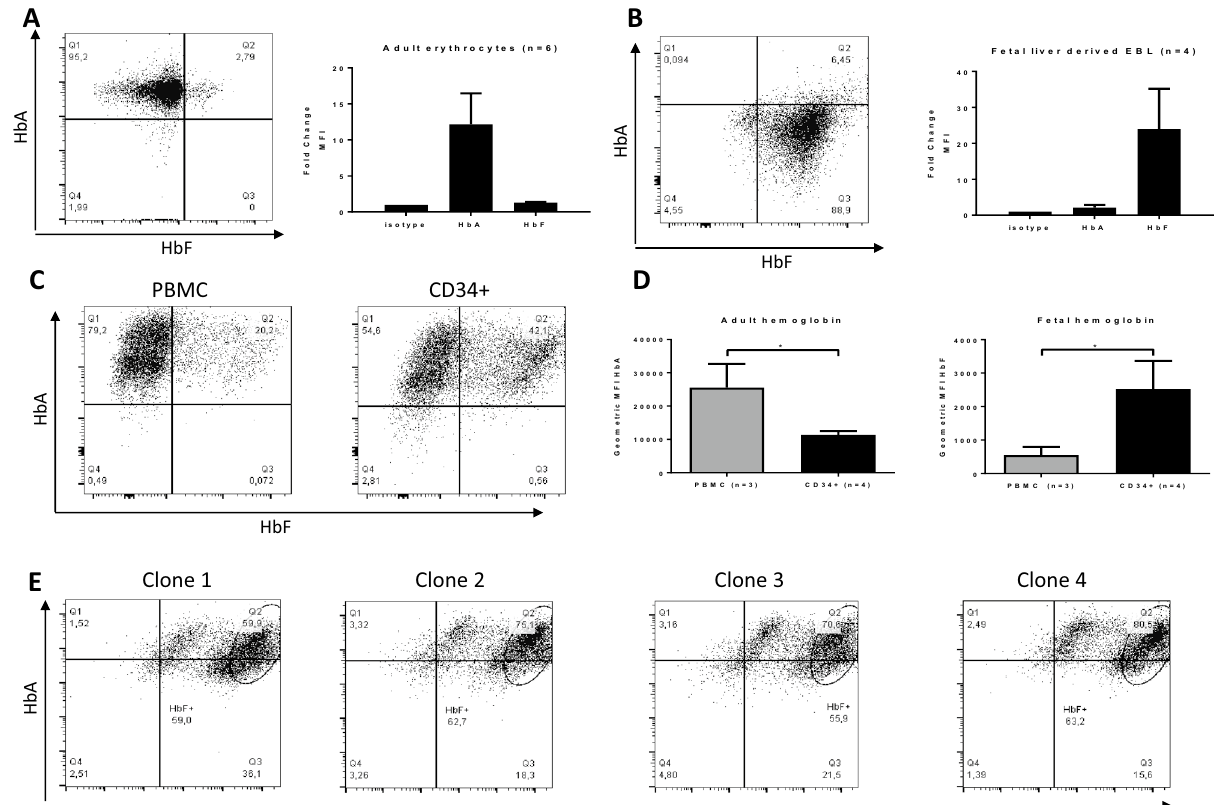
Figure 1. Expression of HbF and HbA is dependent on erythroblasts culture starting material. Erythrocytes from human adult peripheral blood ( A ; n = 6) or human fetal liver ( B ; n = 4) were stained with anti-HBB1 (y-axis) and anti-HBG1/2 (x-axis). Representative dot plots are shown and the histograms indicate the mean fluorescent intensity of the complete globin expressing population. ( C ) erythroblasts were cultured from PBMC or from CD34+ cells isolated from PBMC. Expression of HBB1 and HBG1/2 was measured as indicated in (A). Representative dot plots are shown. ( D ) The histograms indicate the mean fluorescent intensity of the complete globin expressing population (PBMC, n = 3 and CD34+ cells, n = 4; *p < 0.05 Student’s T-test). ( E ) CD34+ cells were single cell sorted and cultured as indicated in material and methods. The dot plots represent anti-HBB1 (y-axis) and anti-HBG1/2 (x-axis) of four different clonal CD34+ -single-cell-derived erythroblast